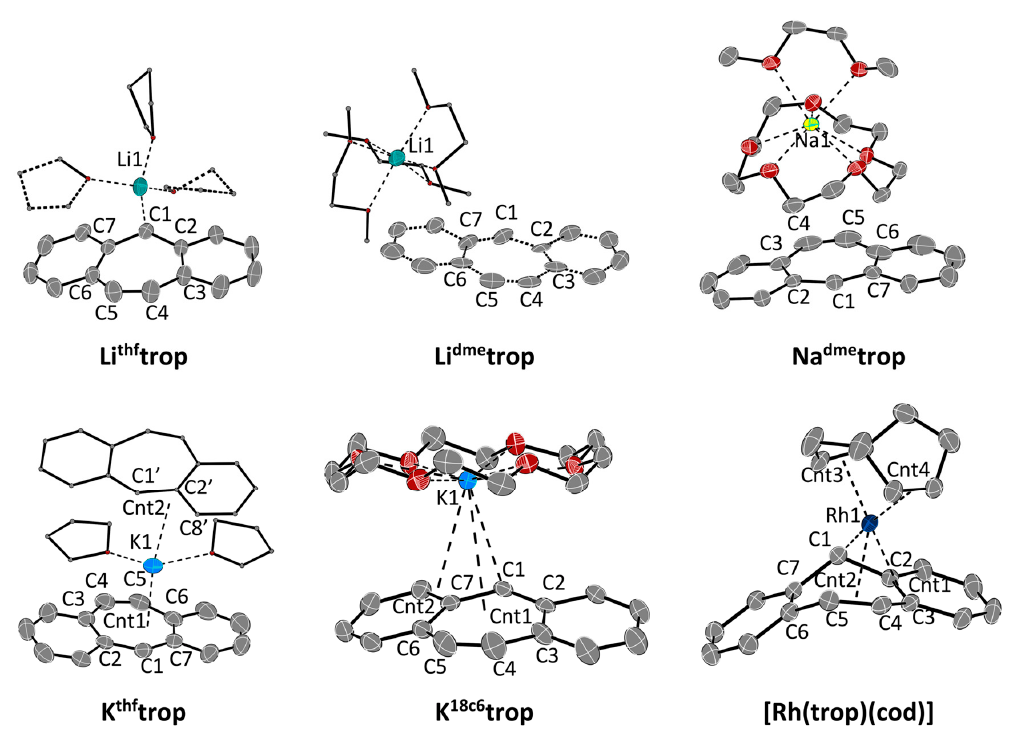
Figure 1. ORTEP plots Li thf trop , Li dme trop , Na dme trop , K thf trop , K 18c6 trop and [Rh(trop)(cod)] at 50% ellipsoid probability (hydrogen atoms are omitted for clarity). Li dme trop : only one of the two distorted trop moieties is shown. [Rh(trop)(cod)] : A co-crystallized toluene-molecule is omitted for clarity.